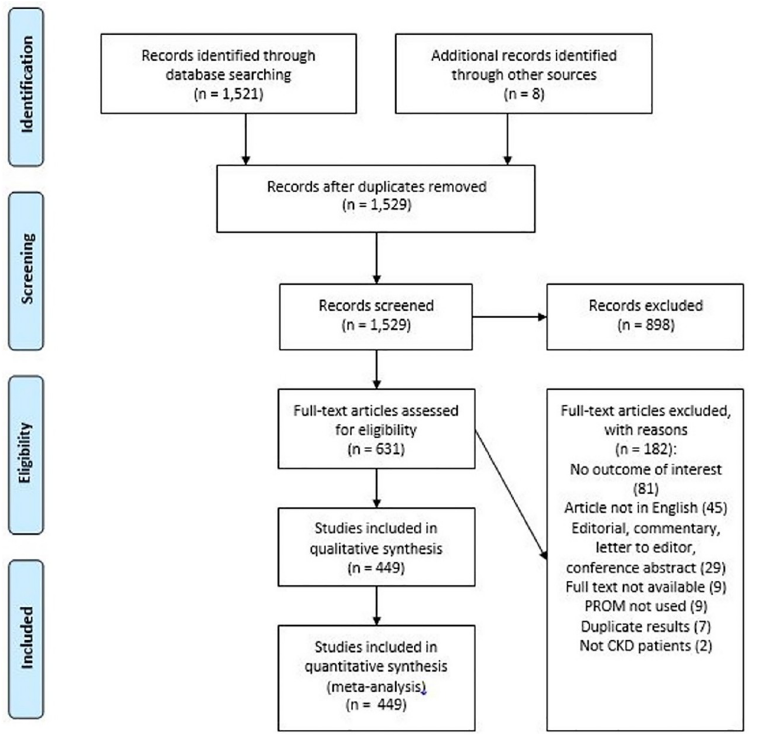
Fig 1. PRISMA diagram. CKD, chronic kidney disease; PROM, patient-reported outcome measure.